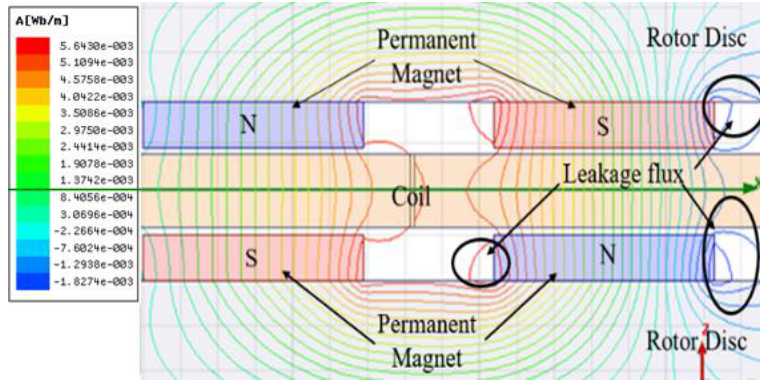
Figure 9. Path of flux lines in NS-type structure used in machine designed.